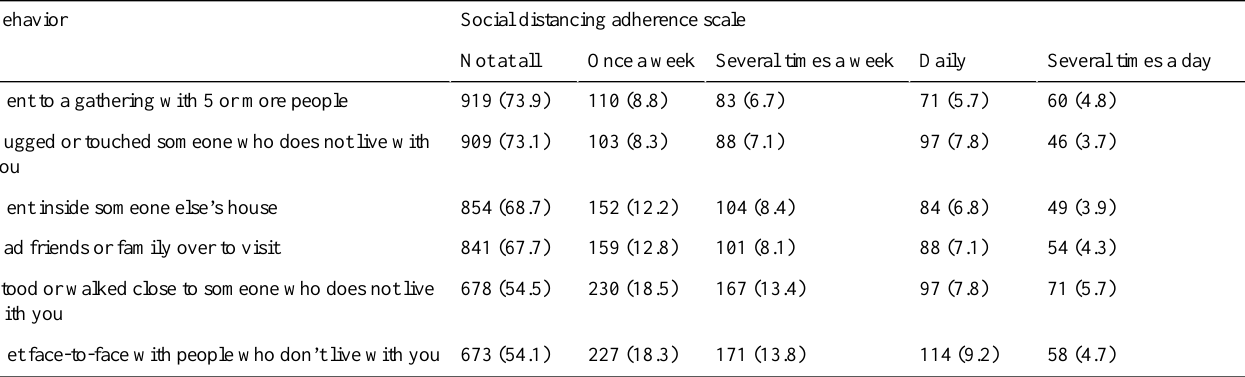
Table 6. Self-reported frequency of social distancing behavior not recommended by the US Centers for Disease Control and Prevention (N=1243), n (%). Note that the statistics include people who did not leave the house for seven